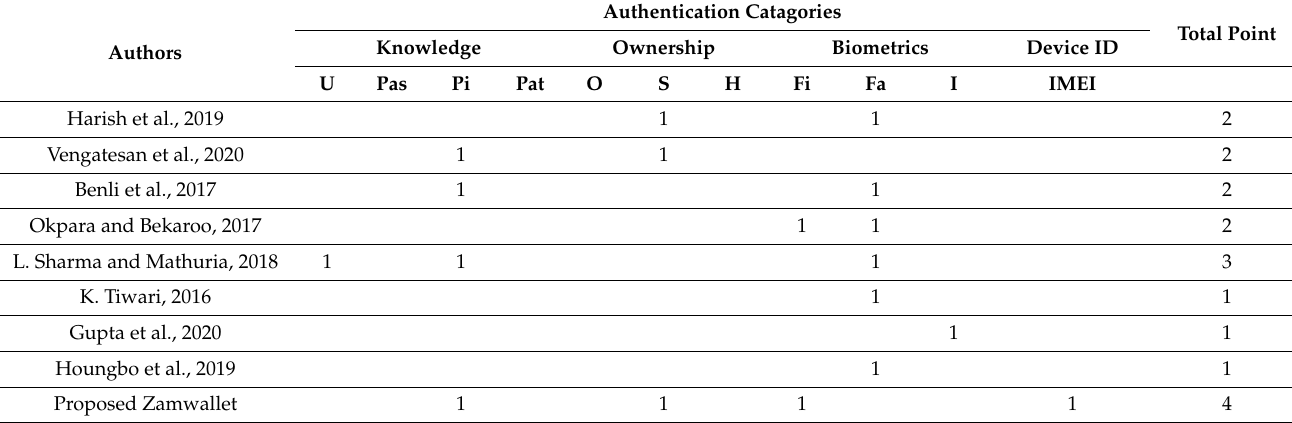
Table 9. Comparison of authentication categories within the proposed scheme and existing